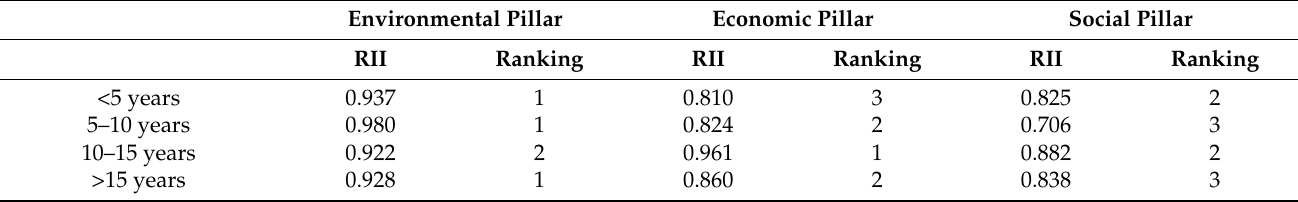
Table 12. Categorized RII ranking of the three pillars of sustainability in terms of their relevance to SC based on the respondents’ years of experience in the construction